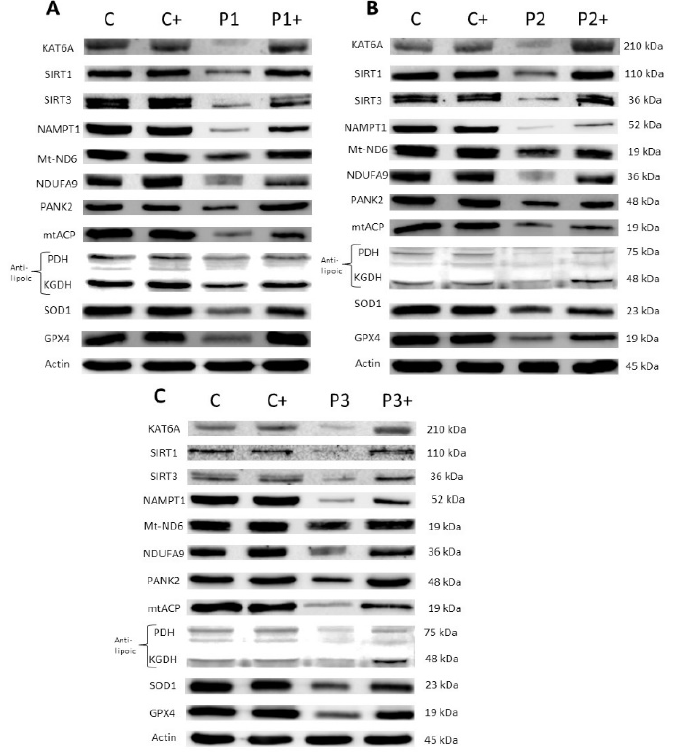
Figure 3. Pantothenate and L-carnitine supplementation improves protein expression levels in mutant KAT6A fibroblasts . Control (C) and mutant P1 and P3 fibroblasts (P1 and P3) were treated with 0.7 µ M pantothenate and 0.7 µ M L-carnitine for 15 days (C+, P1+ and P3+), while Control (C) and P2 fibroblasts (P2) were treated with 0.4 µ M pantothenate and 0.4 µ M L-carnitine for 15 days (C+ and P2+). Immunoblotting analysis of cellular extracts from Control and P1 fibroblasts ( A ), P2 fibroblasts ( B ), and P3 fibroblasts ( C ). Protein extracts were separated on an SDS polyacrylamide gel (12.5%) and immunostained with antibodies against KAT6A protein, SIRT1, SIRT3, NAMPT1, Mt-ND6, NDUFA9, PANK2, mtACP, lipoic acid (lipoylated PDH and lipoylated KGDH), SOD1, GPX4, and actin. A representative actin band is shown, although loading control was additionally checked for every Western blot. Data represent the mean ± SD of three separate experiments. Protein band densitometry is shown in Supplementary Figures S7 and